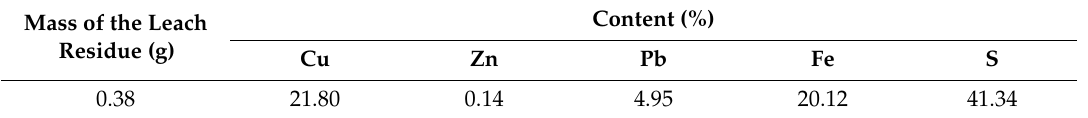
Table 3. Chemical composition of the leach